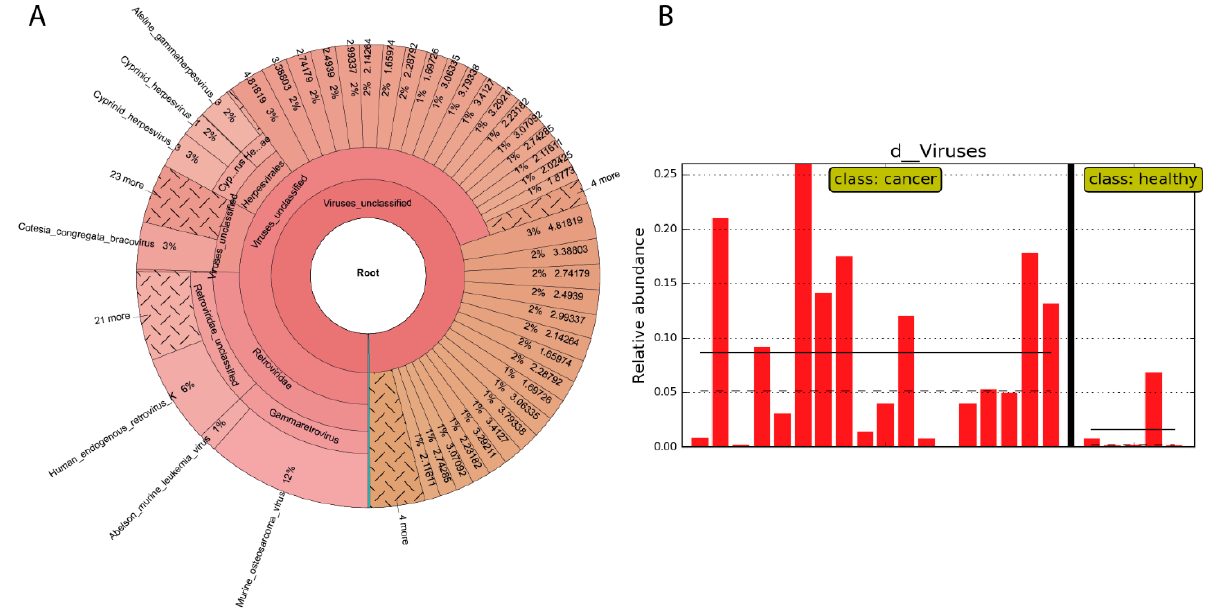
Figure 5. ( A ) Viruses abundance (by Metaphlan3) in breast tissue (both normal and tumour, Slovak donors) visualised by Krona; ( B ) viral transcript numbers identified by Kraken2 in Breast cancer tumours and normal breast tissue of Slovak